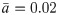
Characterizing individual painters.(a, b) Growth in S of Mondrian’s and Renoir’s paintings, respectively, over the normalized careers of each painter. The slope a of the linear fit (dashed red lines) is 0.62 for Mondrian and −0.10 for Renoir. (c) The histogram of the linear slopes {a} of 1 326 modern artists who produced paintings in at least five distinct years. A few notable artists are indicated. The dashed line indicates the average slope (a¯=0.02, a slight trend towards abstract paintings). (d, e) Painting samples by Mondrian and Renoir, respectively, highlighting their stylistic changes over their careers (All images are obtained from Wiki Art and in the public domain). (f) Singularity of paintings by seven select artists. The darker band indicates the range −1 ≤ z ≤ 1. (g) Histogram of the singularity of 330 artists with more than 40 paintings. The dashed line indicates the average slope (v¯=0.02).